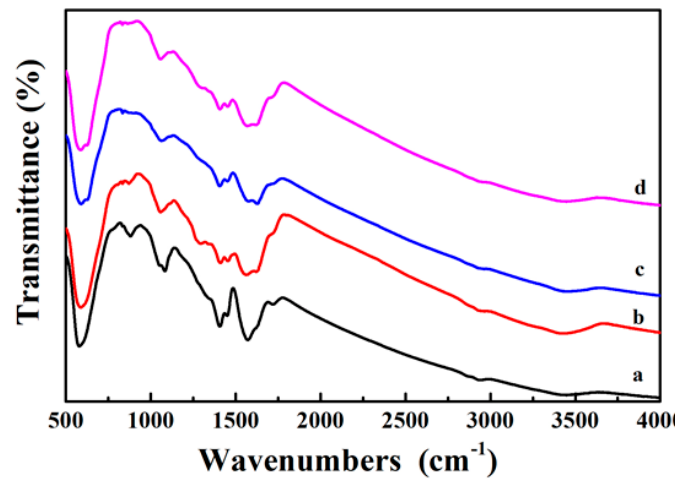
Figure 5. FTIR spectra of the as-prepared samples Fe 3 O 4 ( a ), Fe 3 O 4 @PDA ( b ), Fe 3 O 4 @PDA / Ag ( c ), and Fe 3 O 4 @PDA / Ag / PDA ( d ) nanospheres.